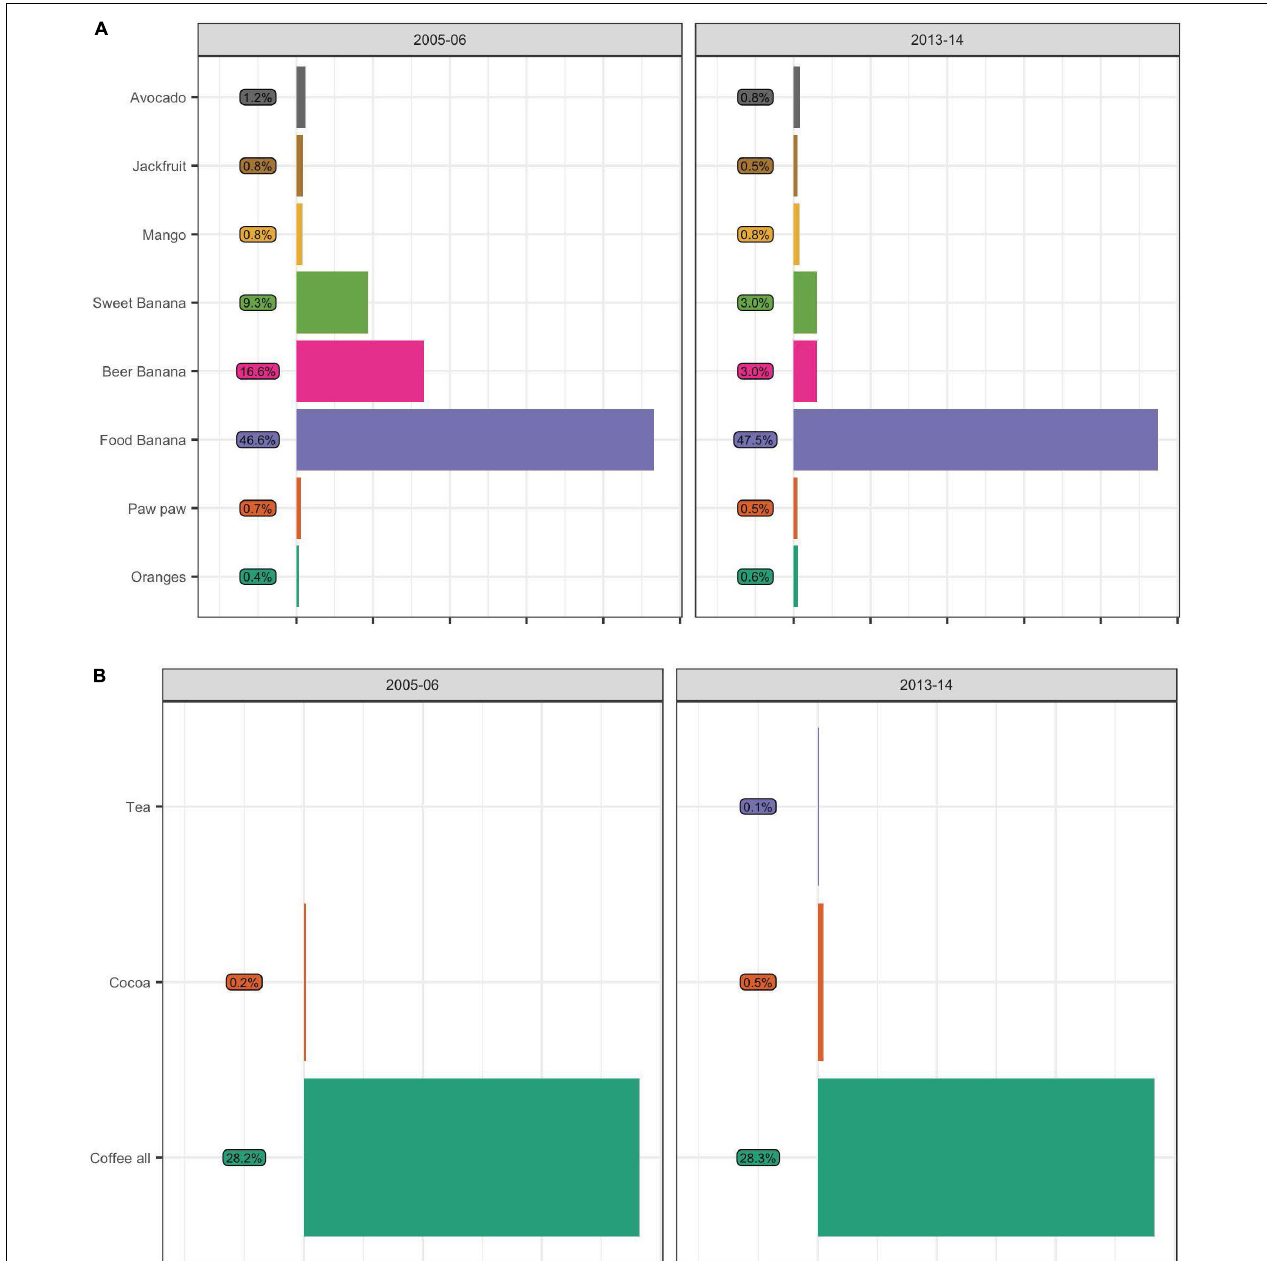
FIGURE 2 | Percent of households reporting trees on farms, by survey wave and type of tree: (A) fruit trees and (B) tree cash crops. n = 1,395 rural households. Data source: UNPS 2005–2006 and